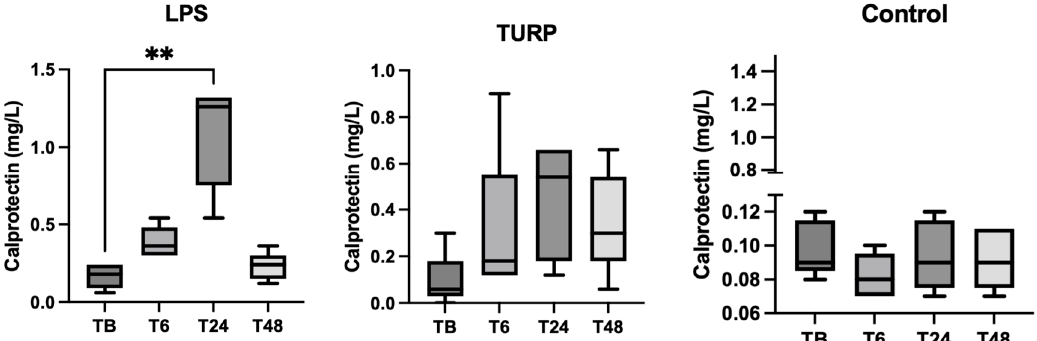
Figure 2. Changes in the salivary calprotectin concentrations of pigs after lipopolysaccharide (LPS), turpentine (TURP) or saline (control) injection. The plots show medians (line within box), 25th and 75th percentiles (boxes) and min and max values (whiskers). Asterisks indicate a statistically significant di ff erence: ** p < 0.01.